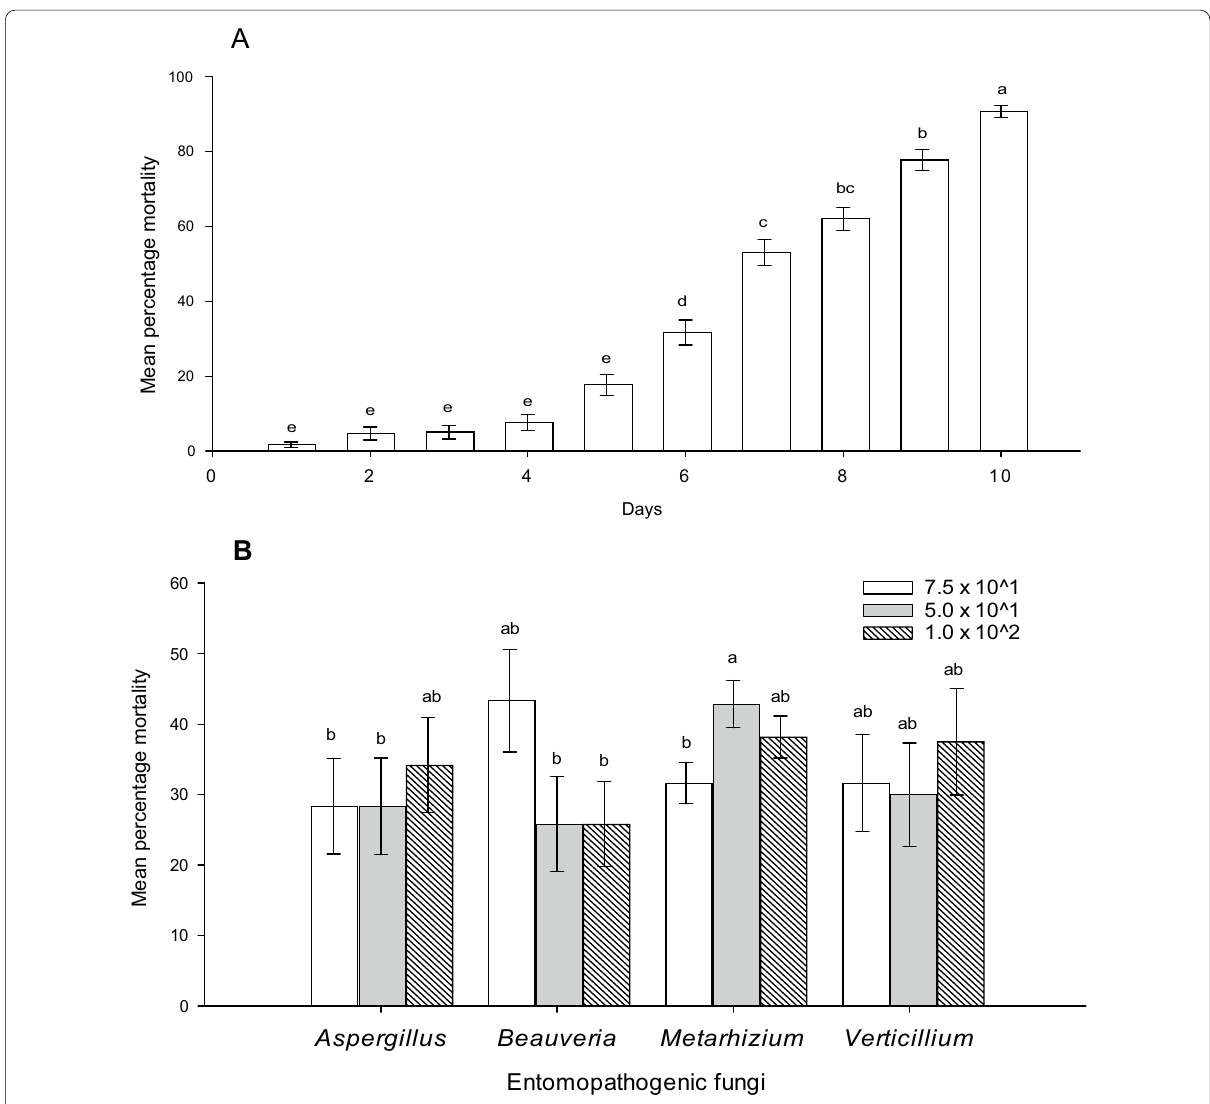
Fig. 2 Mean percentage larval mortality with A time after treatment, B entomopathogenic fungi and concentration. The differential effect of the entomopathogenic fungi on Galleria mellonella larvae. Data are mean ( n 4). Bar with different letters is significantly different, Tukey HSDs ( P < =